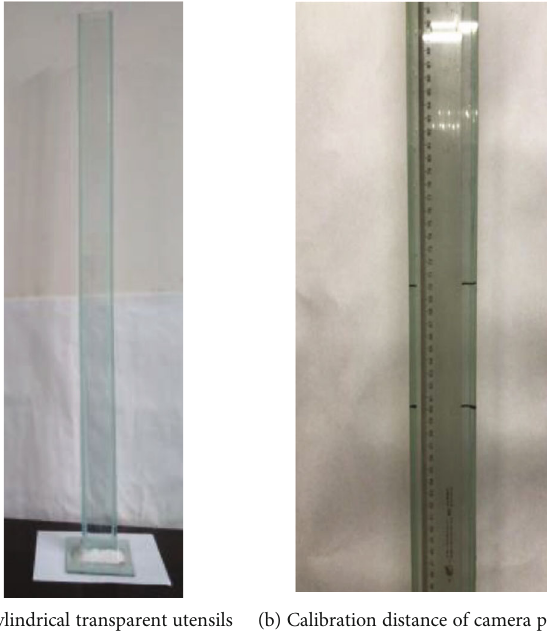
Figure 3: Settling experiment of coal fi nes.